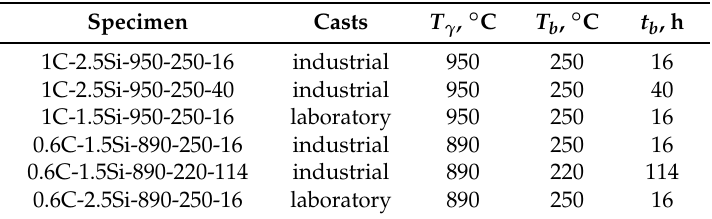
Table 1. Heat treatment of the investigated specimens. T γ and T b are the austenitization and austempering temperature, respectively, and t b is the austempering time. The austenitization time is 1 h for all specimens. Specimen Casts T γ , ◦ C T b , ◦ C t b ,